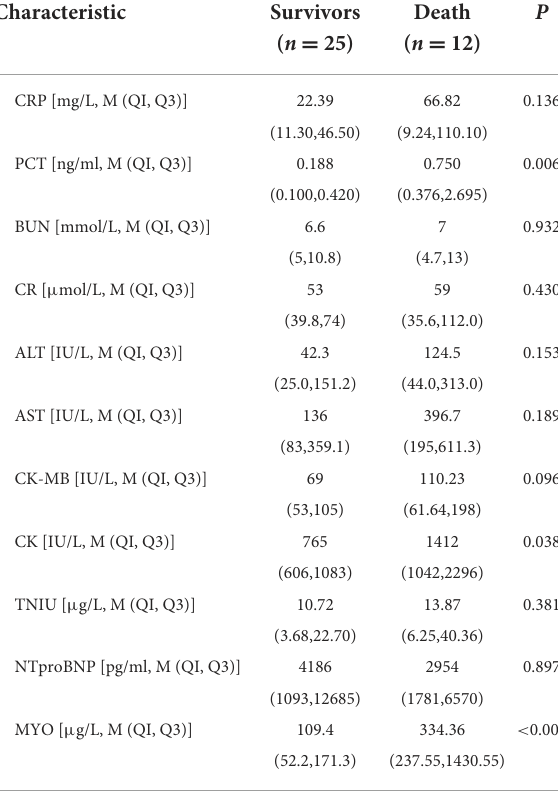
TABLE 1 Comparison of basic conditions and clinical manifestations of children with FM.